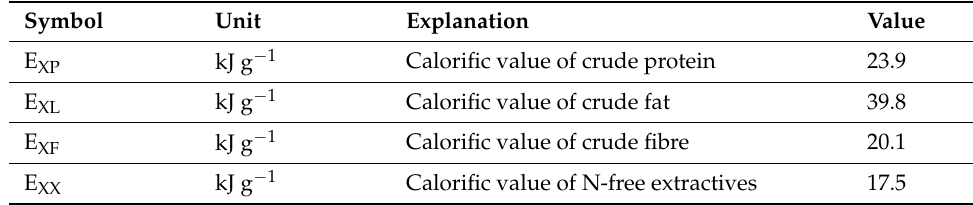
Table A6. Calorific value of biomass content.